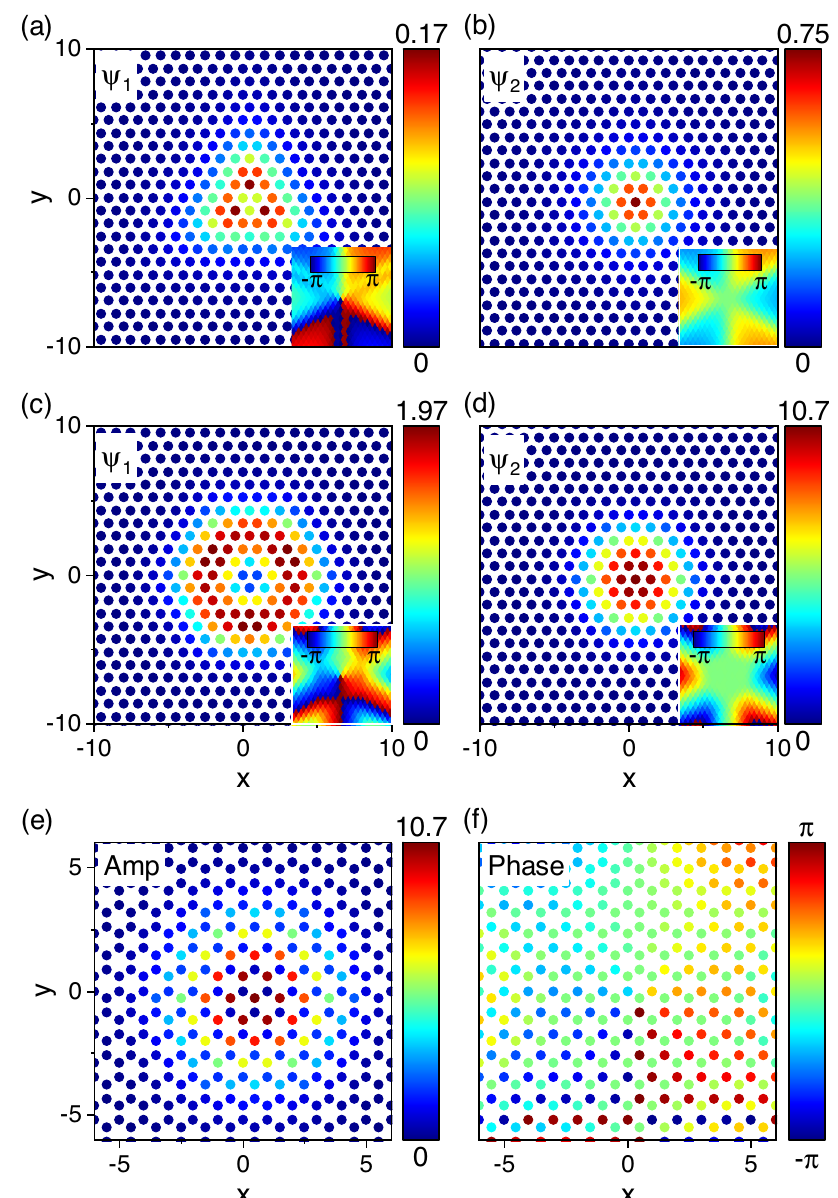
Fig. 8 Discrete bulk solitons. Discrete bulk solitons at K valley under the self-focusing nonlinearity with g = 1. a , b The amplitudes of the two pseudospin components ψ of the discrete bulk soliton with the frequency ω = 9.1. c , d The amplitudes of the two pseudospin components ψ 1 ; 2 soliton with the frequency ω = 9.9. The color bars in a – d denote the amplitudes and the insets in a – d are the phases. The full lattice distribution of the discrete bulk soliton with the frequency ω = 9.9, where the color bars in e and f correspond to the amplitude and phase,